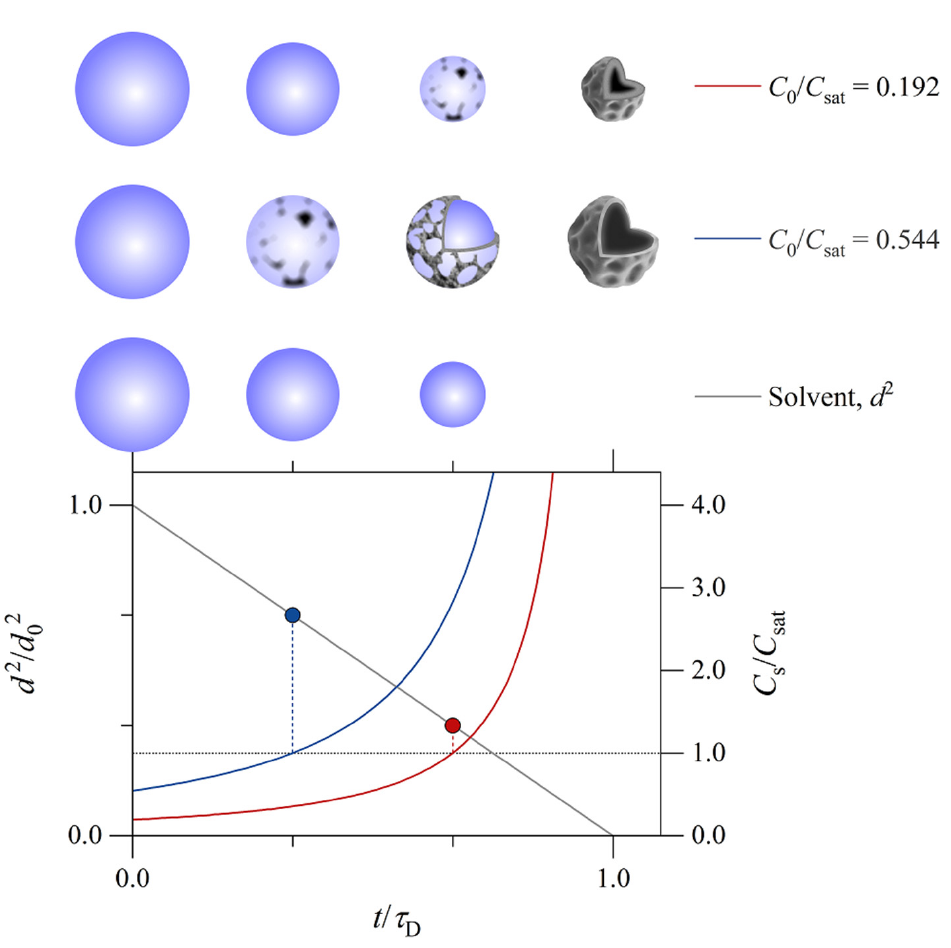
Figure 6. An illustration of the time required for the solute to reach saturation at the surface of a drying droplet. The temporal evolution of the droplet surface area (black line, left axis) was calculated assuming that the droplet surface area decreases linearly with time. The droplet surface area is presented as a fraction of the initial droplet surface area, where d is the droplet diameter and d 0 is the initial droplet diameter. The temporal evolution of the solute concentration at the surface of the drying droplet was calculated using Equation (4) (red and blue lines, right axis). The solute concentration at the surface of the drying droplet, C s , is presented as a fraction of the saturation solubility of the solute in the spray droplet/solution, C sat . The initial concentration of the solute in the spray droplet/solution, C 0 , was set to 0.192 C sat (red) and 0.544 C sat (blue). Particle formation is illustrated for the two situations. The dotted horizontal line corresponds to surface saturation, i.e., C s = C sat . The time, t , is presented as a fraction of the droplet drying time, τ D .